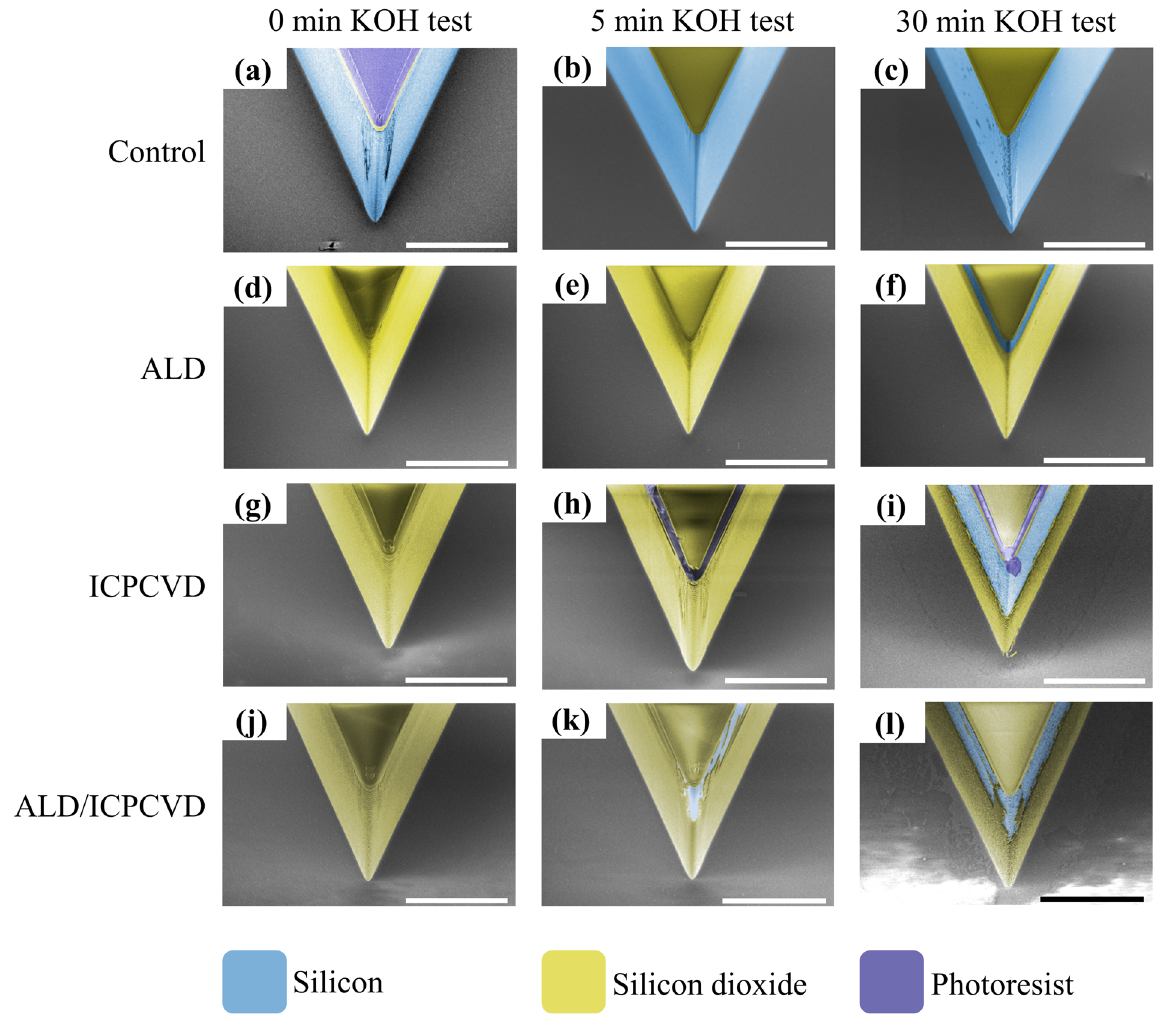
Fig. 1 Front view SEMs of device tips showing progressive etching of the silicon and SiO 2 sidewalls during the KOH etch test. The columns correspond to etch durations of 0 min, 5 min, and 30 min, while the rows represent deposition methods. False coloring indicates different materials. The less exposed silicon (blue) on the sidewalls, the better the protection. The scale bars are 50 µm. The control group (top row, a – c ) suffered the most etching whereas the ALD fi lm (second row, d – f ) provided the best protection. The ICPCVD (third row, g – i ) and ALD/ICPCVD (fourth row, j – l ) fi lms showed obvious etching over time. Partial exposure of silicon through SiO 2 is visible in ( f ), ( i ), ( k ), and ( l